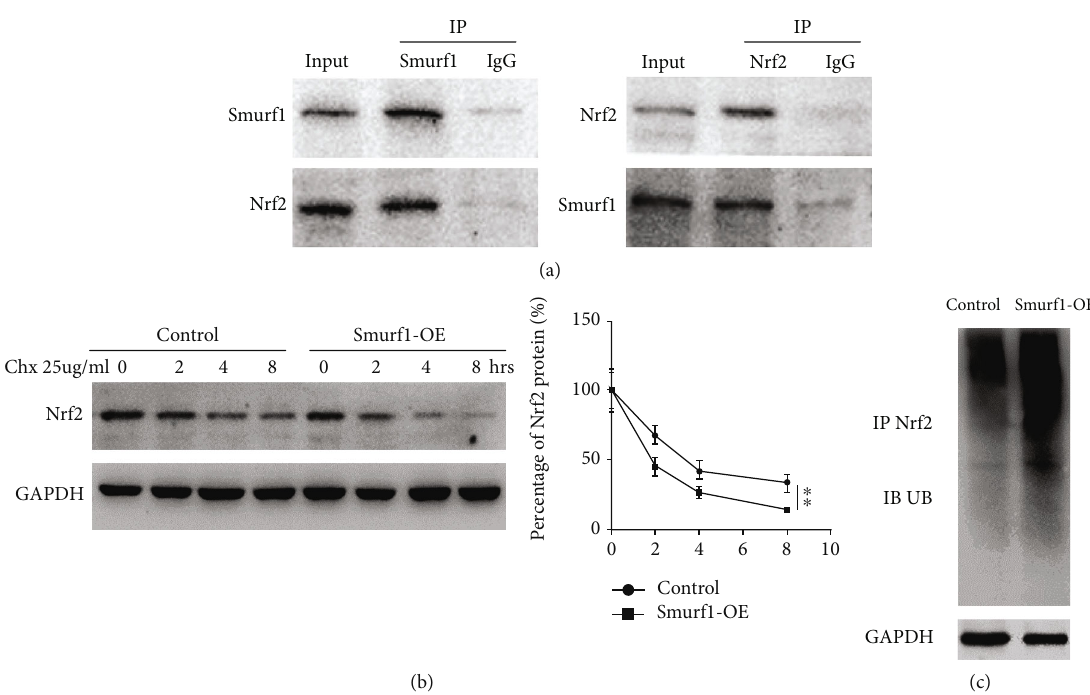
Figure 6: Smurf1 promotes the ubiquitination and degradation of Nrf2. (a) Smurf1 directly interacts with Nrf2 was assessed by CO-IP. (b, c) Western blot analysis of Nrf2 protein stability in Smurf1-OE LF cells treated with 25 u g/ml CHX for various times. ∗∗ p < 0 : 01 . (d) Cell lysates from control and Smurf1-OE LF cells was immunoprecipitated with anti-Nrf2 antibody, then assesed by western blot using antiubiquitin (Figure 4(e)) and the downregulation of GSH content and